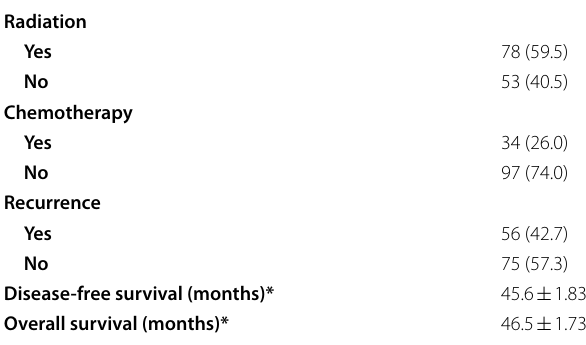
Table 1 Patient and tumor characteristics of patients with tongue squamous cell carcinoma